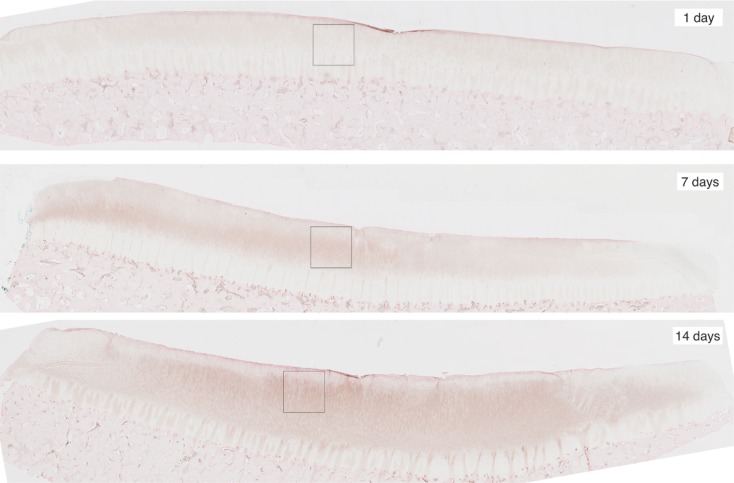
Slices of articular cartilage created at 1, 7, and 14 days after a single blunt impact. The impact site appears as a dent at the top of each image. The squares in each region are the zoomed areas shown in Figure 3. These slices have been stained to measure EPO concentrations, which are shown to increase as time progresses.